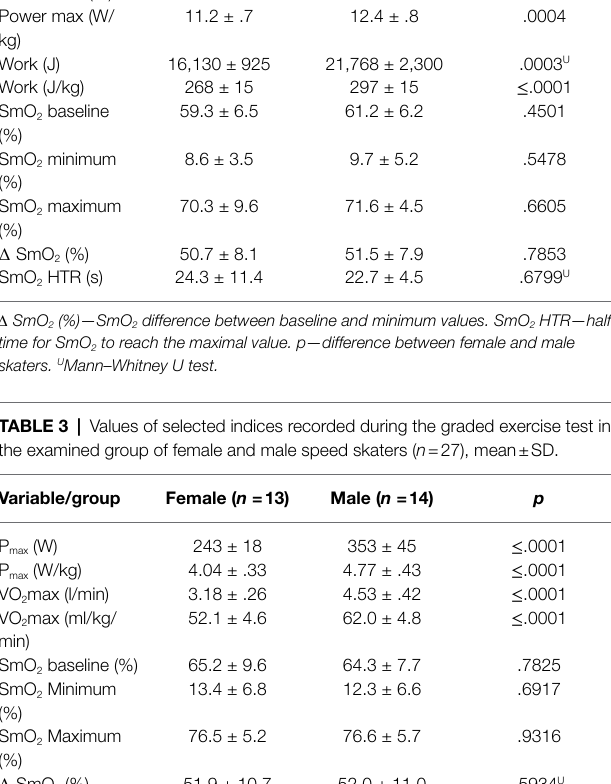
TABLE 2 | Values of selected indices recorded during the Wingate test in the examined group of female and male speed skaters ( n = 27), mean ± SD. Variable/group